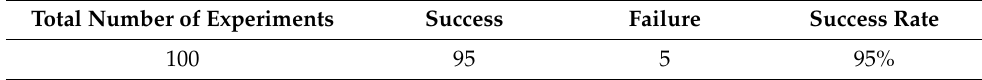
Table 8. Capture success rate for three-way